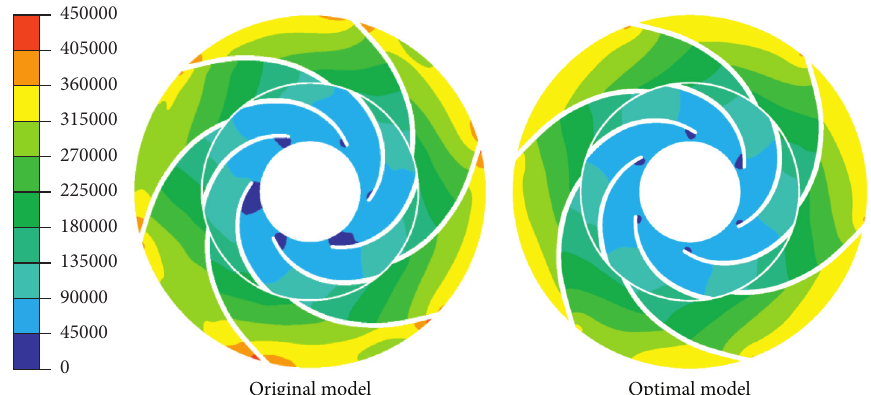
Figure 17: Comparison of pressure distribution 1.0 Q